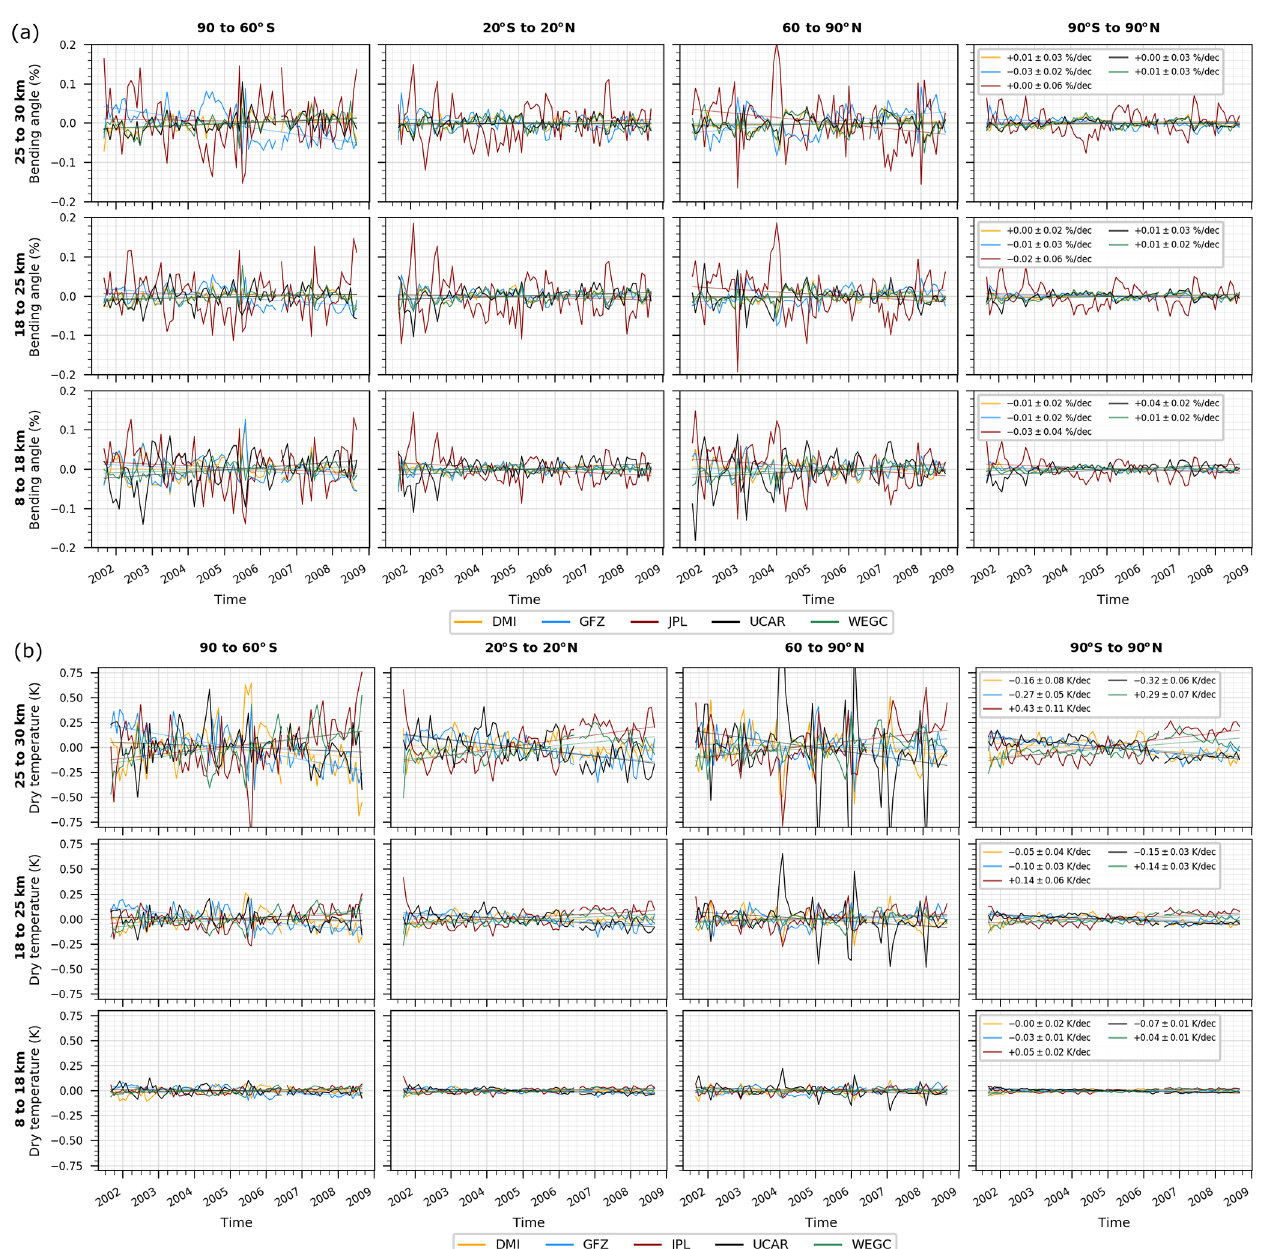
Figure 4. CHAMP bending angle (a) and dry temperature (b) de-seasonalized anomaly difference time series based on 10 ◦ zonal medians of each center to the all-center mean for latitude bands 90 to 60 ◦ S, 20 ◦ S to 20 ◦ N, 60 to 90 ◦ N, and globally 90 ◦ S to 90 ◦ N (left to right) for altitude layers 8–18, 18–25, and 25–30km (bottom to top). Time series from DMI (orange), GFZ (blue), JPL (red), UCAR (black), and WEGC (green) are